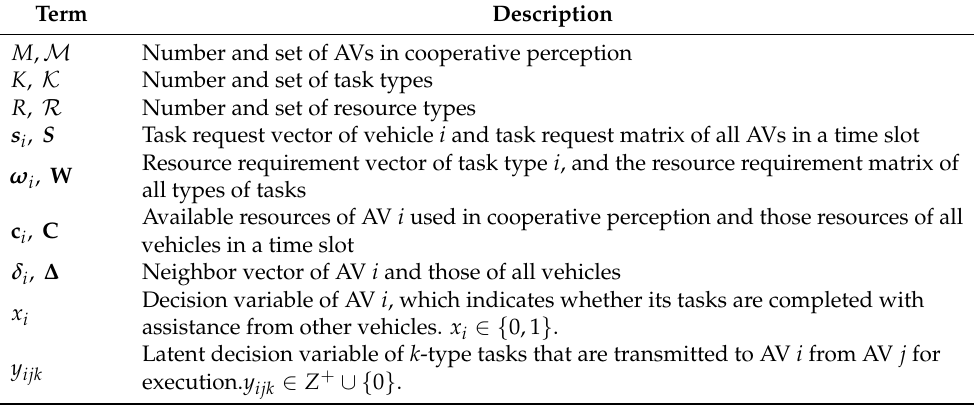
Table 2. Main annotations used in the